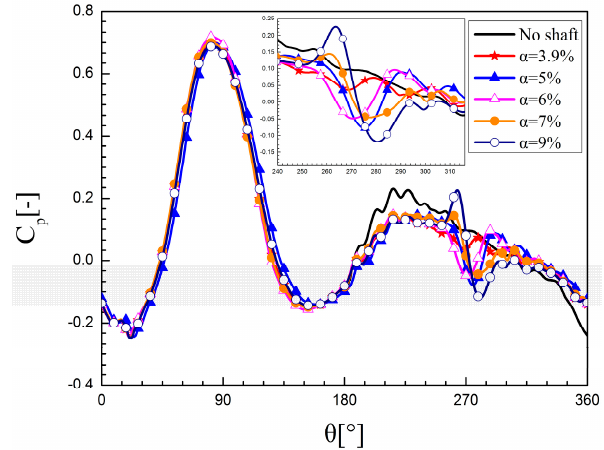
Figure 7. Comparison of instantaneous power coefficient in one revolution with respect to different values of wind turbine diameter ( α ).